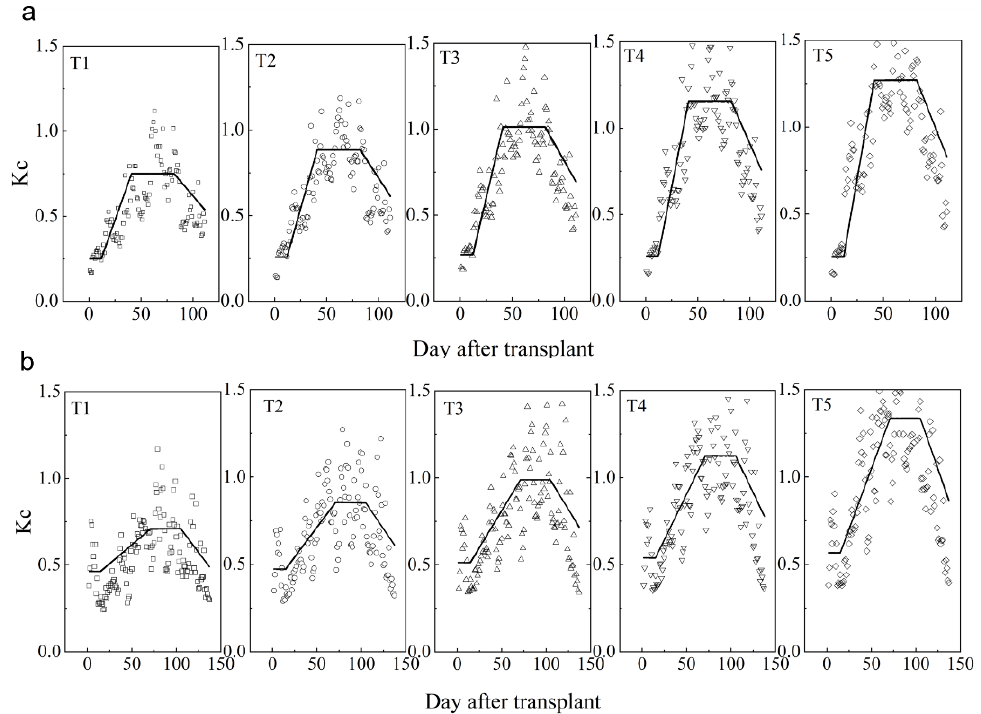
Figure 6. Variation trend for the tomato crop coefficient (K c ) in the autumn–winter season ( a ) and winter–spring season ( b ).